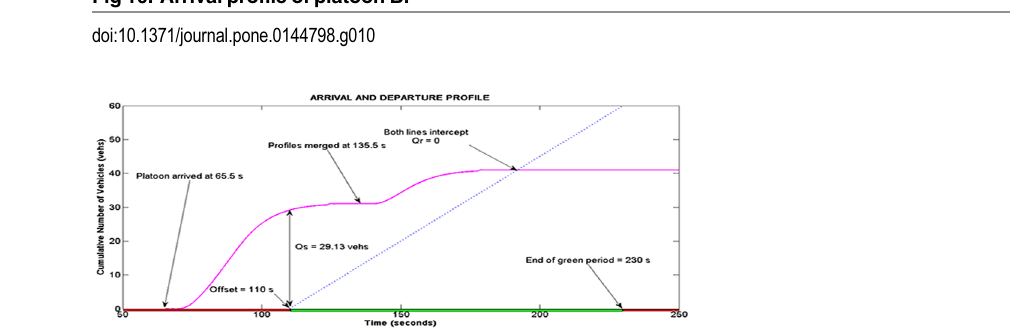
Fig 10. Arrival profile of platoon B.